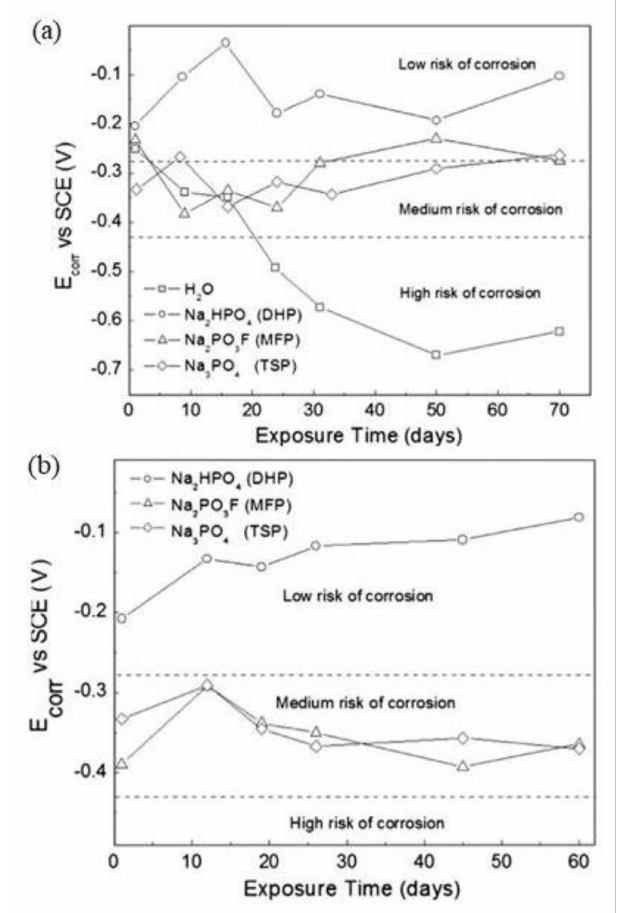
Figure 15. Corrosion potential ( E corr ) versus time for steel in the presence of: ( a ) migrating corrosion inhibitor (MCI) and ( b ) admixture corrosion inhibitor (ACI) [43]. Reproduced with permission from Bastidas, D.M. et al., Cem. Conc. Comp.; published by Elsevier,